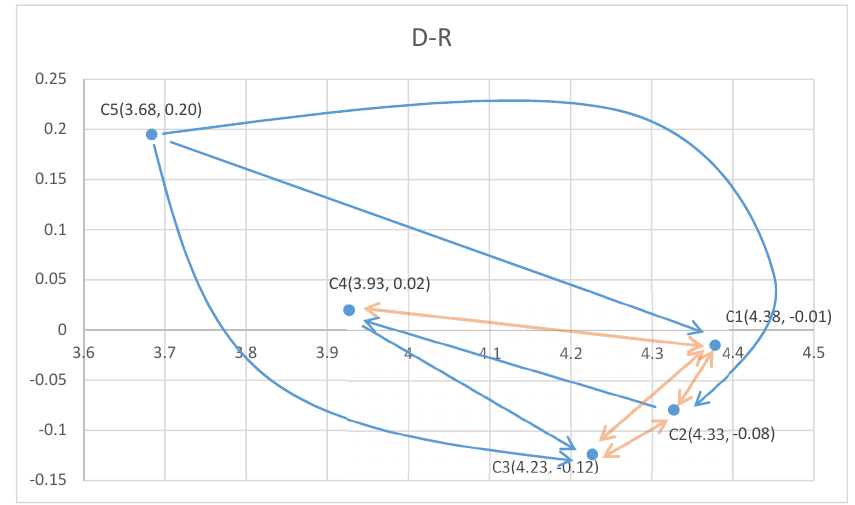
Figure 5. Sca(cid:308)er plot of the correlation (D + R) and causality (D − R) results for the social aspect. Figure 5. Scatter plot of the correlation (D + R) and causality (D − R) results for the social